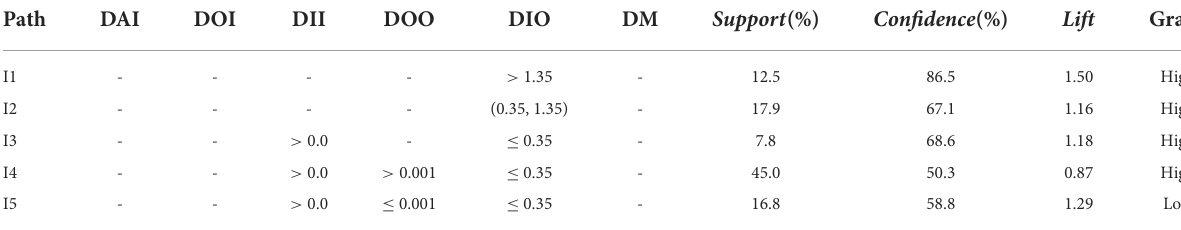
TABLE 3 Green innovation performance (GIP) decision rule table for excellent digitalization